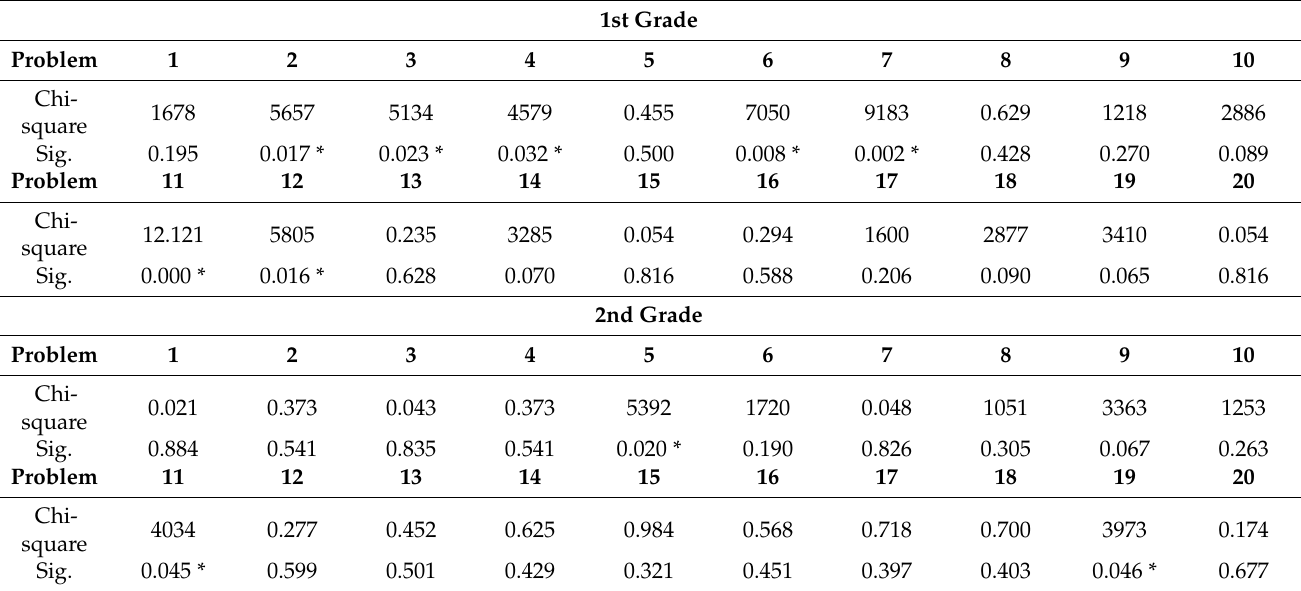
Table 4. Differences in problem solving based on the coincidence or lack of coincidence between the first language and the language of instruction.